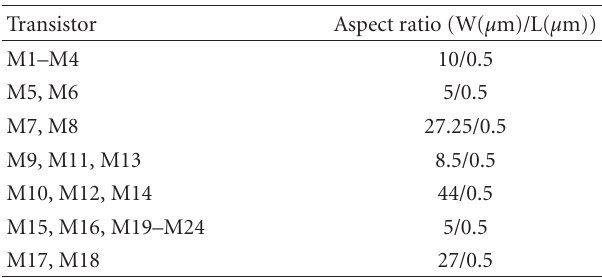
Table 1: Aspect ratio of various